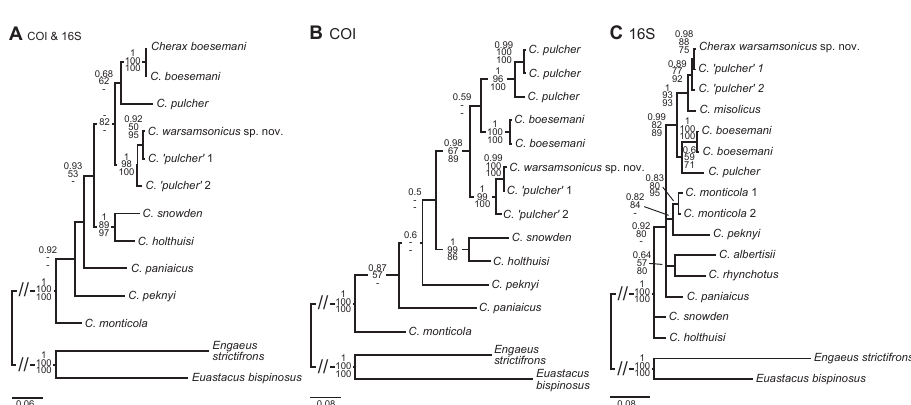
Figure 7. Phylogenetic position of Cherax warsamsonicus sp. n. within closely related New Guinean Cherax species, reconstructed by BI analyses of two mitochondrial gene fragments. Number on branches show, from top, Bayesian posterior probabilities and ML/MP bootstrap values. The scale bar indicates the substitution rate. See Table 1 for information on the sequenced specimens. A Topology based on concatenated COI and 16S dataset B Topology based on COI dataset C Topology based on 16S